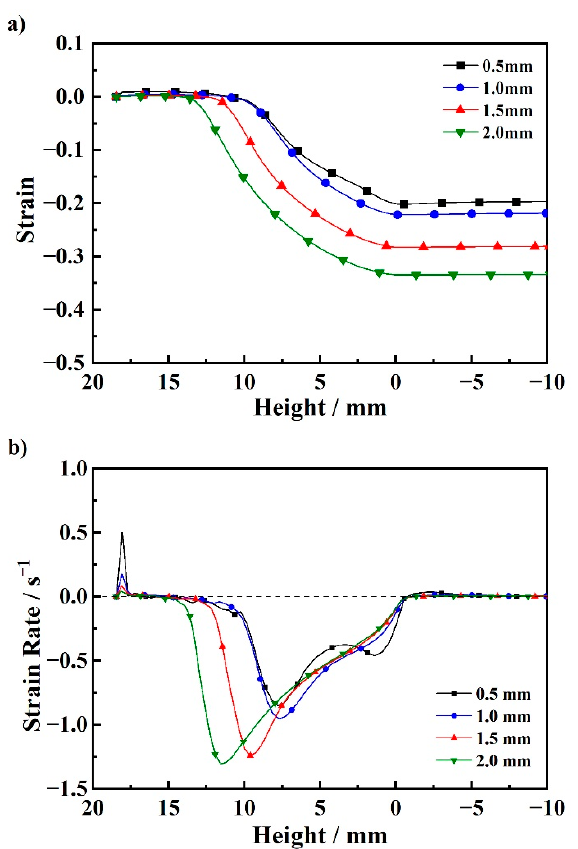
Figure 8. Curves of strain and strain rate of clad in SLS-TRC with different clad thickness. ( a ) Strain curves; ( b ) Strain rate curves.